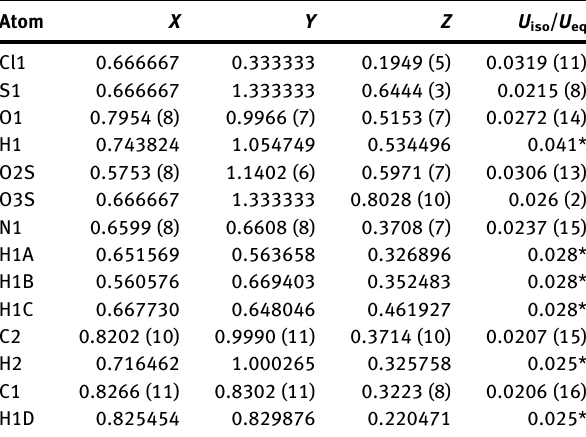
Table  : Fractional atomic coordinates and isotropic or equivalent isotropic displacement parameters (Å  ). The sign (*) distinguishes the isotropicparameters(U iso *)fromequivalentisotropicparameters(U eq ) Atom X Y